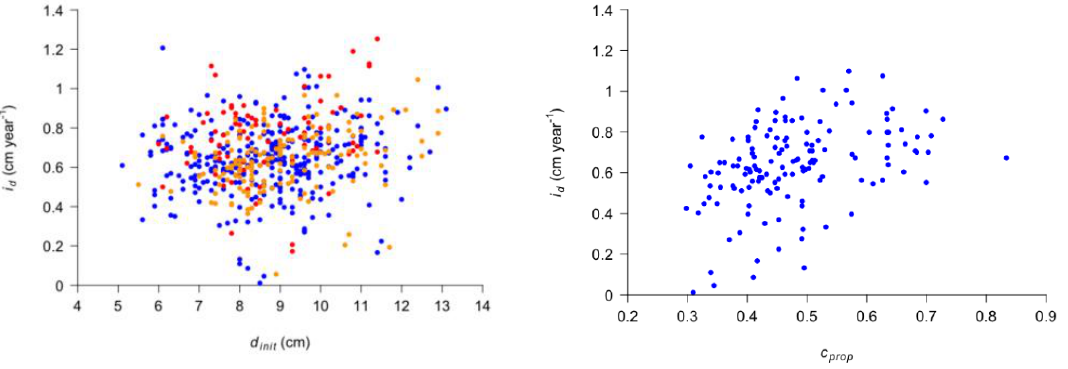
Figure 4. Experiment 1278. Left: individual tree growth ( i d ) for crop trees of treatments PT300 and T600 vs. initial stem dbh ( d init ). Right: individual tree growth ( i d ) for pruned crop trees of treatment T600 vs. remaining crown proportion ( c prop ). Legend: PT300 unpruned = yellow, T600 unpruned = red, T600 pruned = blue.